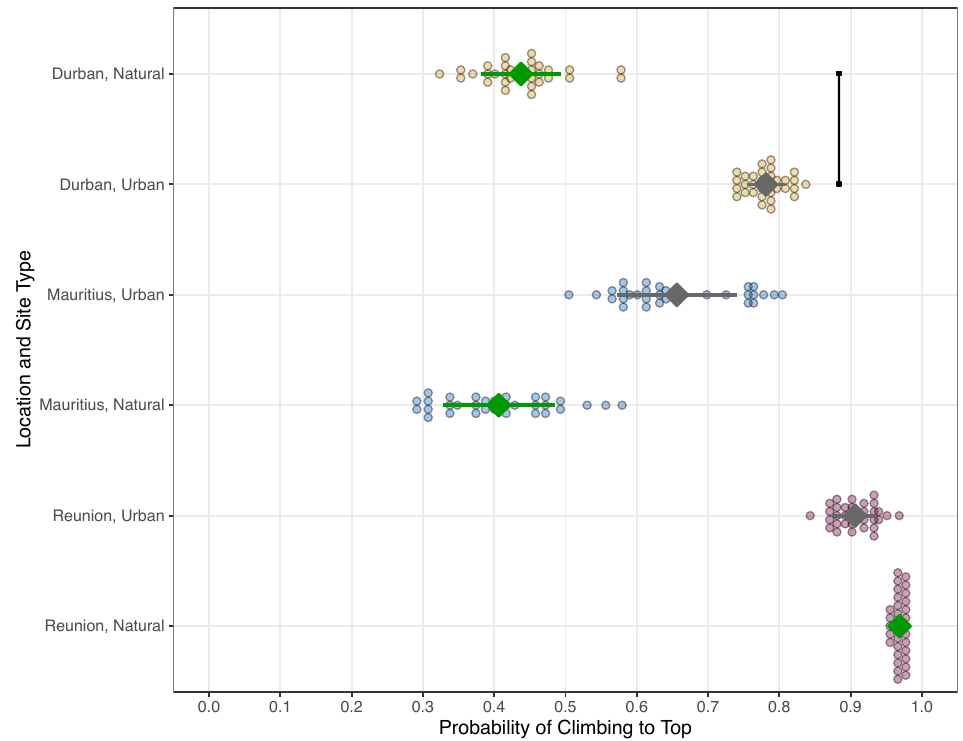
Figure 3. Likelihood of successful climbing trial completion (i.e., climbing ability) for guttural toads ( Sclerophrys gutturalis ) from natural (gray diamonds) and urban (green diamonds) sites in Durban (yellow points), Mauritius (blue points), and R é union (burgundy points). Significant differences along the hypothesized guttural toad invasion routes are highlighted using a black line with squares at the end. Climbing ability significantly increased between natural and urban sites in Durban. The significance values of other comparisons are presented in Table